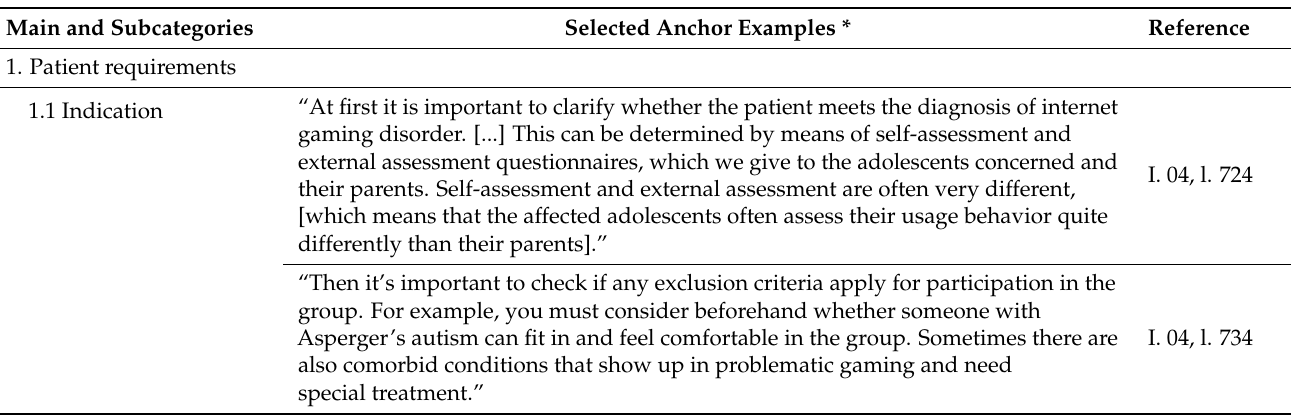
Table 4. Main categories and subcategories of the expert interviews with their anchor examples. Main and Subcategories Selected Anchor Examples *